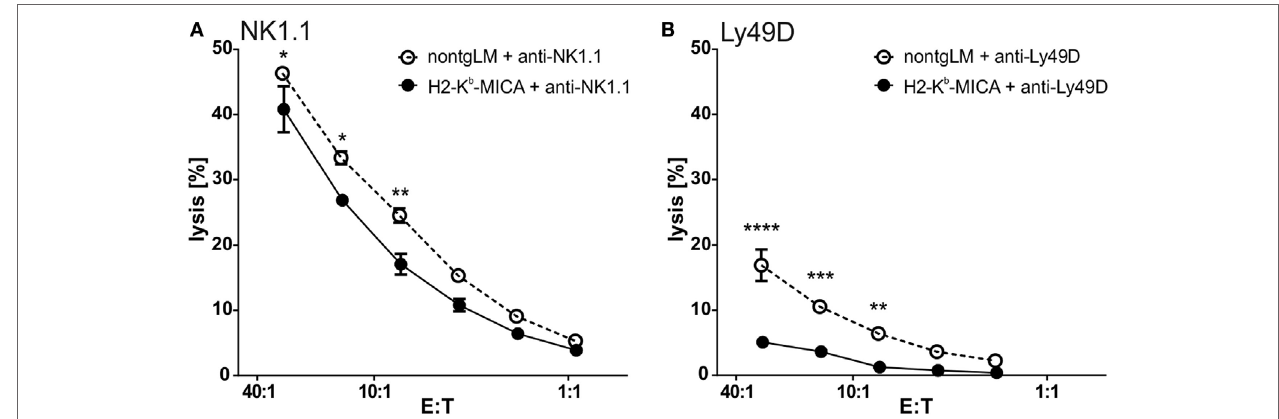
FigUre 5 | Ly49D-mediated cytotoxicity is severely impaired by chronic engagement of NKG2D in vivo . (a,B) Redirected lysis of P815 cells loaded with (a) anti-NK1.1 or (B) anti-Ly49D antibodies by poly(I:C)-activated splenic NK cells. Data represent means of triplicates with SDs. One representative out of four independent experiments is shown. Two-way ANOVA was performed with a Sidak posttest for